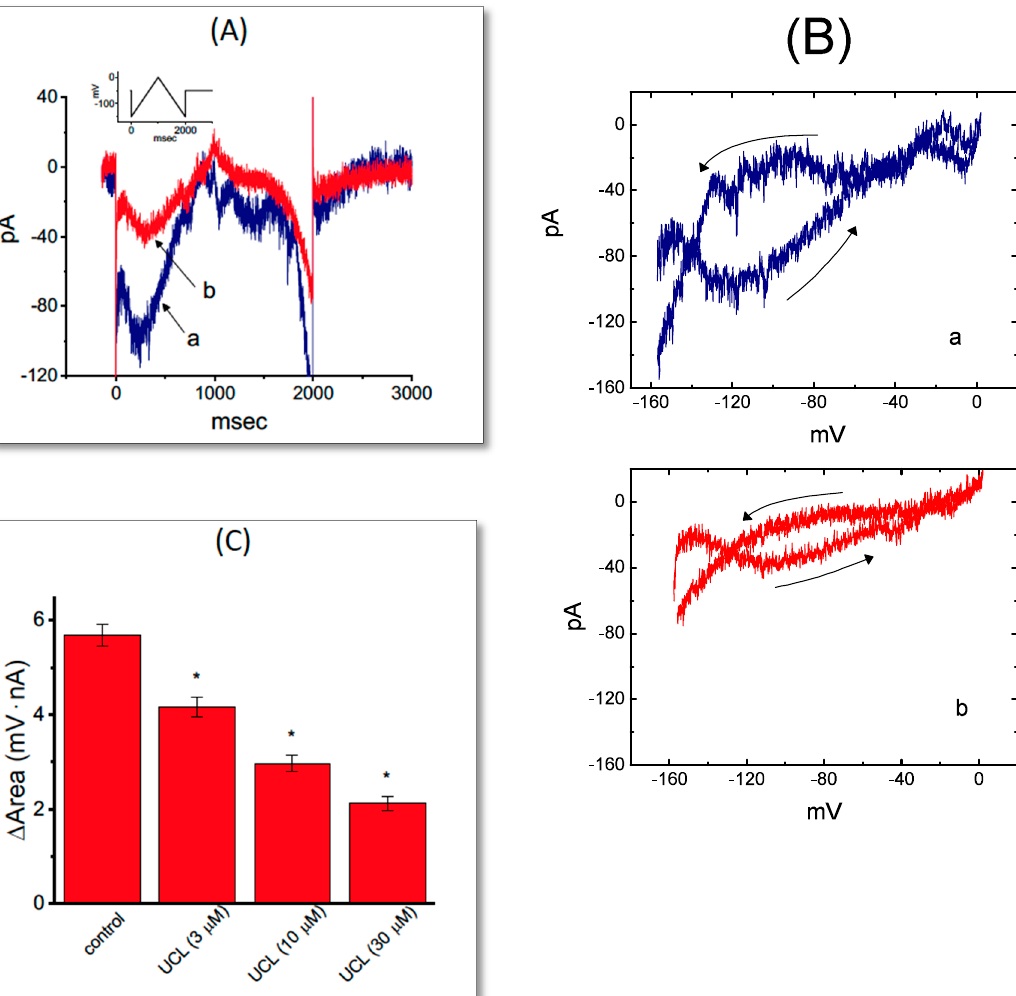
Figure 4. E ff ect of UCL-2077 on the voltage hysteresis of I K(erg) identified from GH 3 cells. ( A ) Original current trace elicited in response to 2-sec long-lasting triangular (i.e., upsloping and downsloping) ramp pulse between − 150 and 0 mV. The inset in ( A ) shows the voltage protocol delivered. Current trace labeled a is control, while that labeled b was obtained in the presence of 10 µ M UCL-2077. ( B ) Voltage hysteresis of I K(erg) measured from the absence (a) or presence (b) of 10 µ M UCL-2077. Arrows indicate the direction of I K(erg) in which time passes. ( C ) Summary bar graph showing the e ff ect of UCL-2077 on the ∆ area of voltage hysteresis (mean ± SEM, n = 7 for each bar). * Significantly di ff erent from control ( p <